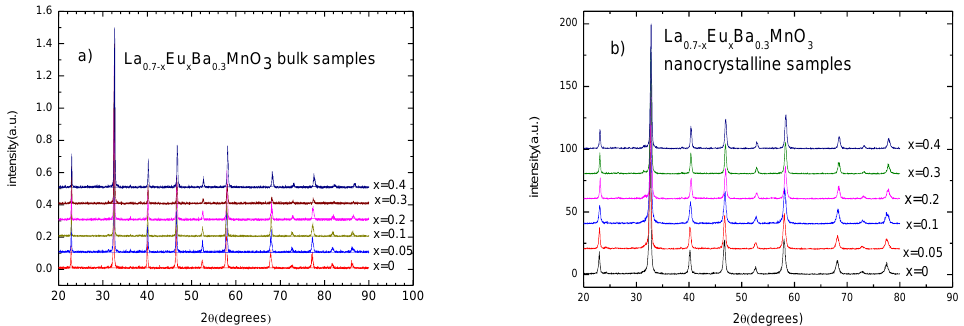
Figure 1. X-ray diffraction patterns for ( a ) La 0.7 − x Eu x MnO 3 polycrystalline bulk samples and ( b ) La 0.7 − x Eu x MnO 3 nano-sized samples.